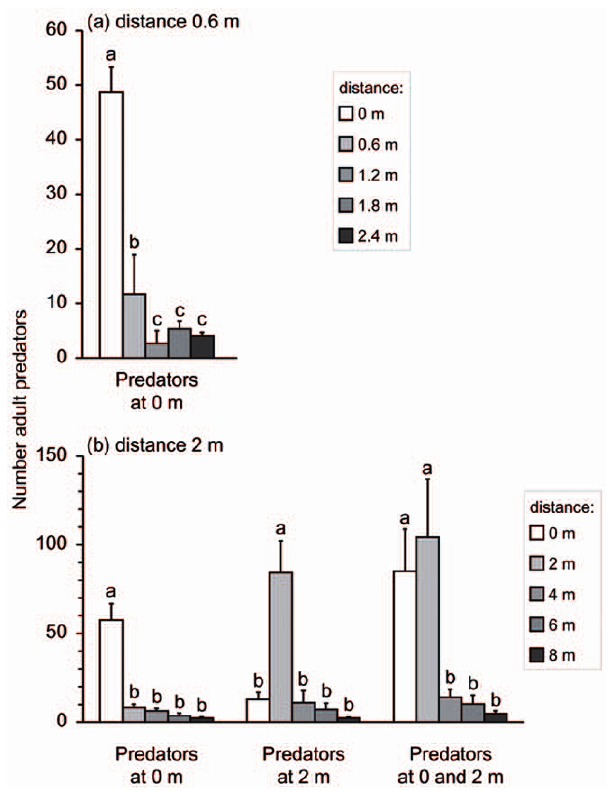
Figure 1. The average ( + s.e.m.) numbers of predatory mites ( A. swirskii ) on plants 28 days after they were released. (a) Distance between neighbouring plants 0.6 m. Predators were released on the plant at 0 m, on which whiteflies were also released. The average number of predators differed among plants (GLM, F 4,10 =14.7, P , 0.001). (b) Distance between neighbouring plants 2 m. Predators were either released on the plant on which whiteflies were released at 0 m (Predators at 0 m), on the plant at 2 m (Predators at 2 m) or both on the plant at 0 and 2 m (Predators at 0 and 2 m). The average number of predators differed among plants in all three treatments (Predators at 0 m: F 4,15 =44.0, P , 0.001; Predators at 2 m: F 4,15 =17.3, P , 0.001; Predators at 0 and 2 m: F 4,15 =12.4, P , 0.001). Within each treatment, bars with different letters differ significantly (contrasts after model simplification). See Table 1 for a summary of the release schedule.